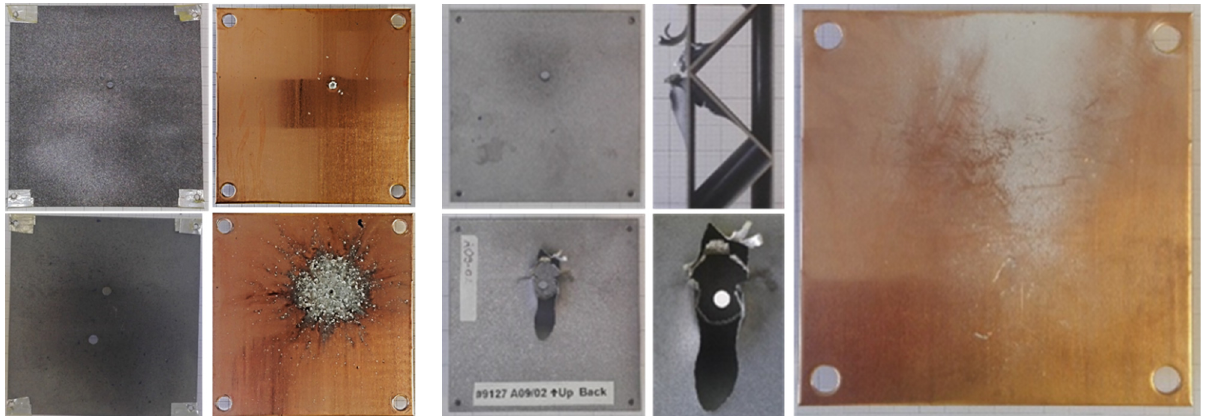
Figure 6. Pictures of 3D-printed samples subjected to impact tests and the copper witness plates placed behind them [43]. On the left, impact tests on simple plates (2.9 mm projectile at 1 km/s, top, and 5 km/s, bottom). On the right, test on a multi-layer corrugated panel (2.9 mm at 4.8 km/s).